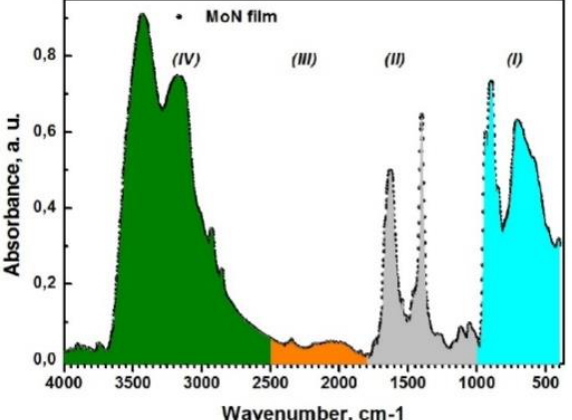
Fig. 2. FTIR (Fourier-transform infrared) spectra of the MoN films in the 400-4000 cm −1 spectral